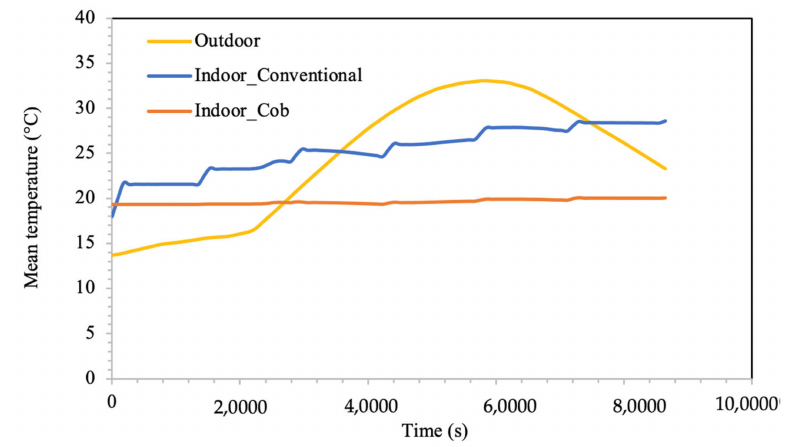
Figure 15. Indoor and outdoor temperature during the hottest day.